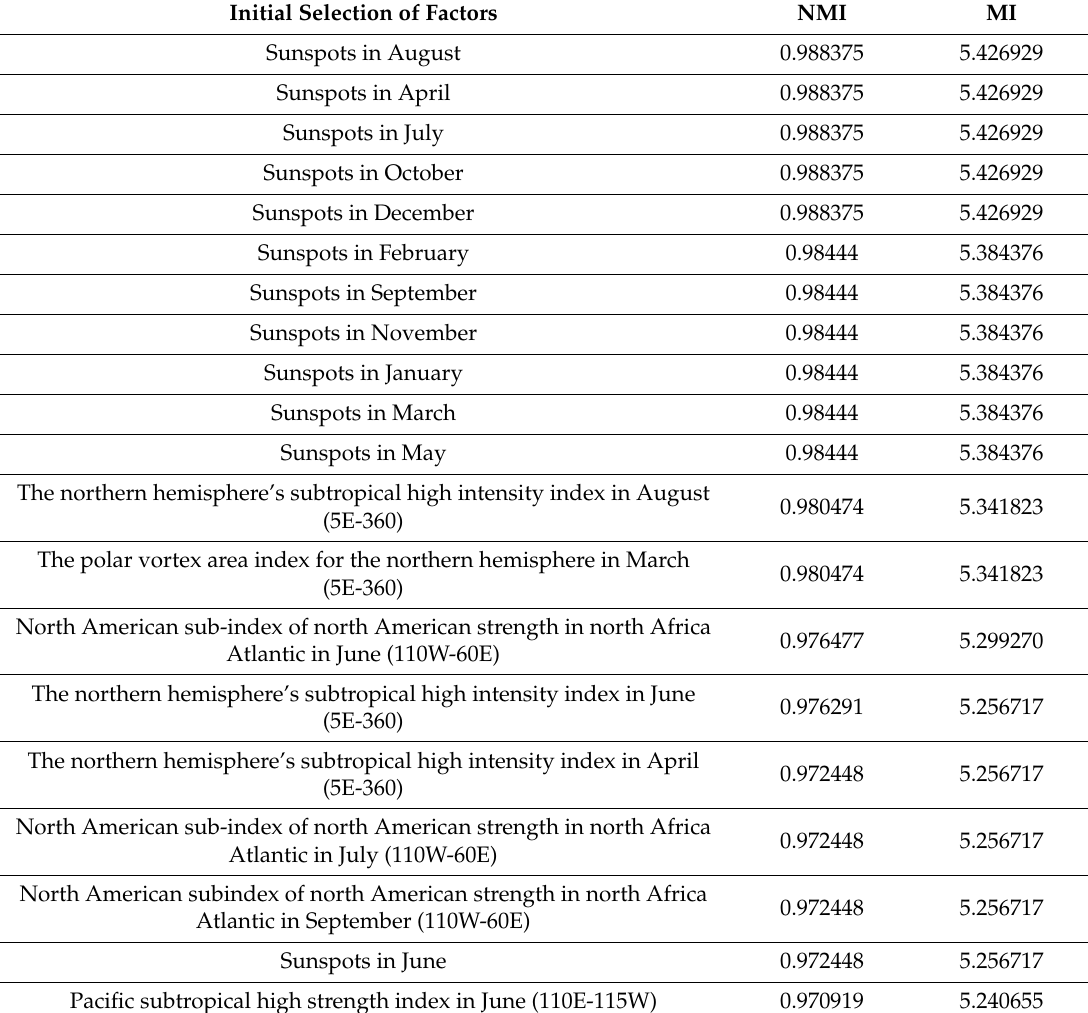
Table 2. The first 20 factors of normalized mutual information greater than